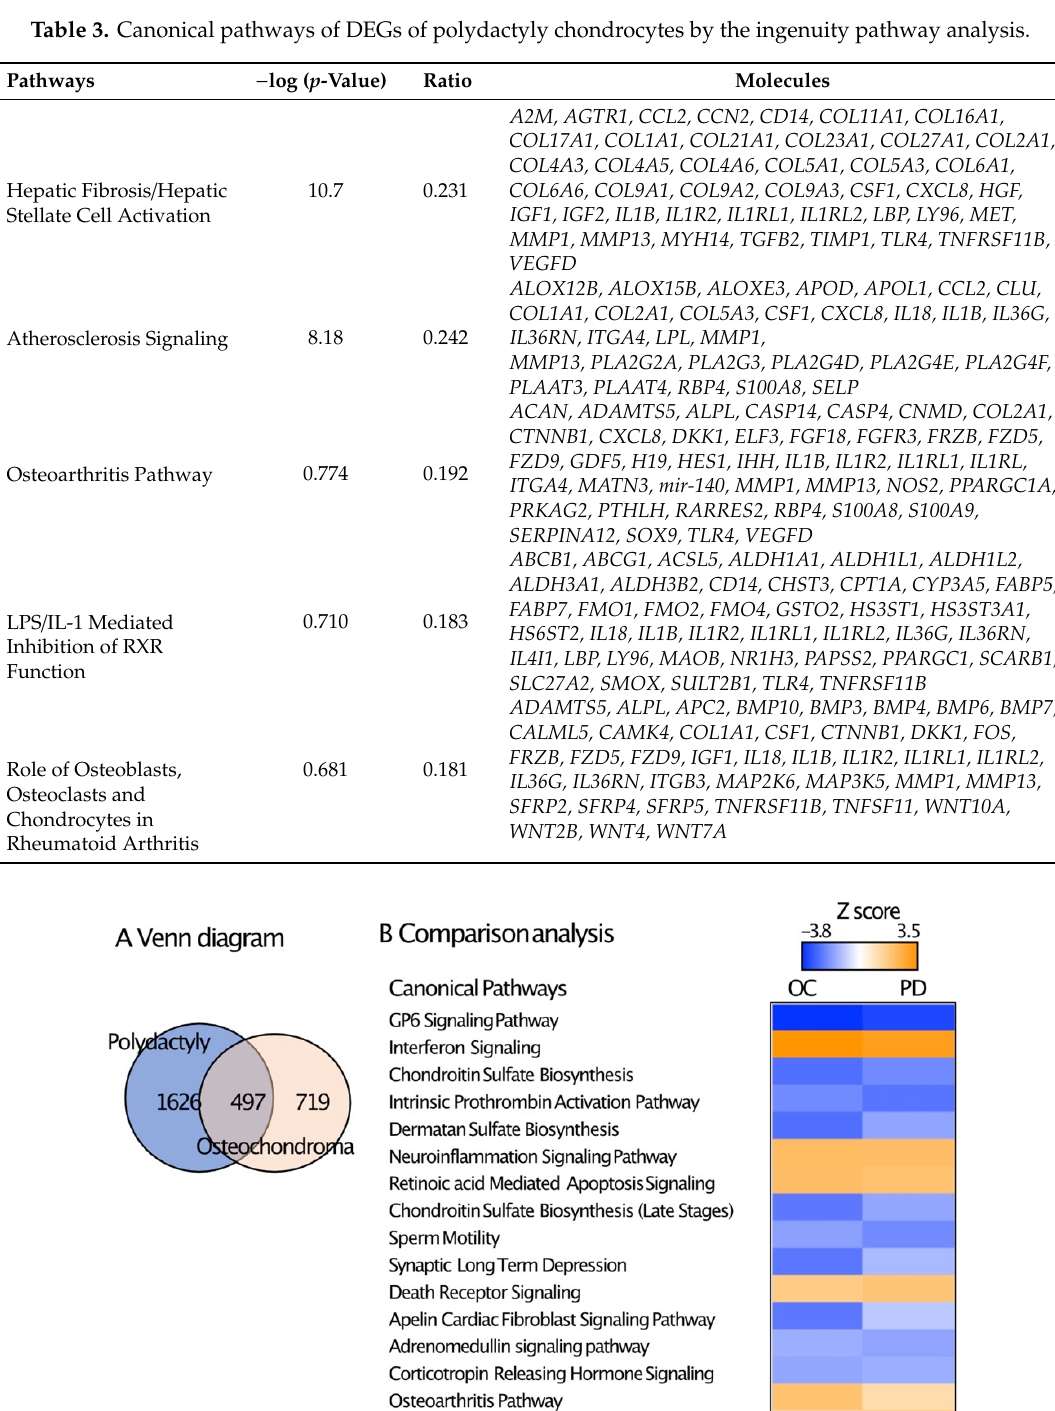
Table 3. Canonical pathways of DEGs of polydactyly chondrocytes by the ingenuity pathway analysis. Hepatic Fibrosis / Hepatic Stellate Pathways − log ( p -Value) Ratio Molecules